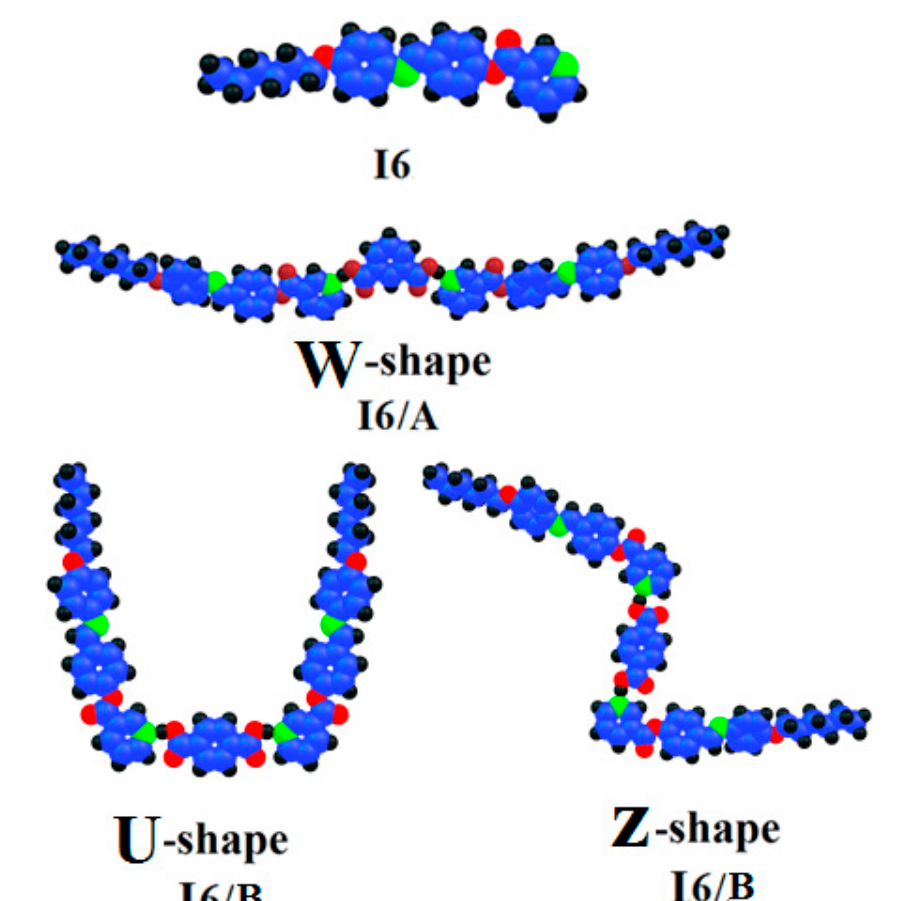
Figure 4. The calculated molecular geometry of the I6/A and I6/B SMHBCs.